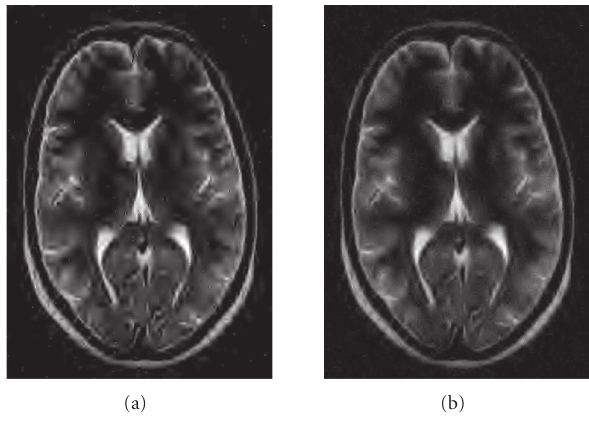
Figure 1: (a) Original image. (b) Image with artificial additive Gaussian white noise, with PSNR = 2 . 55 (dB).